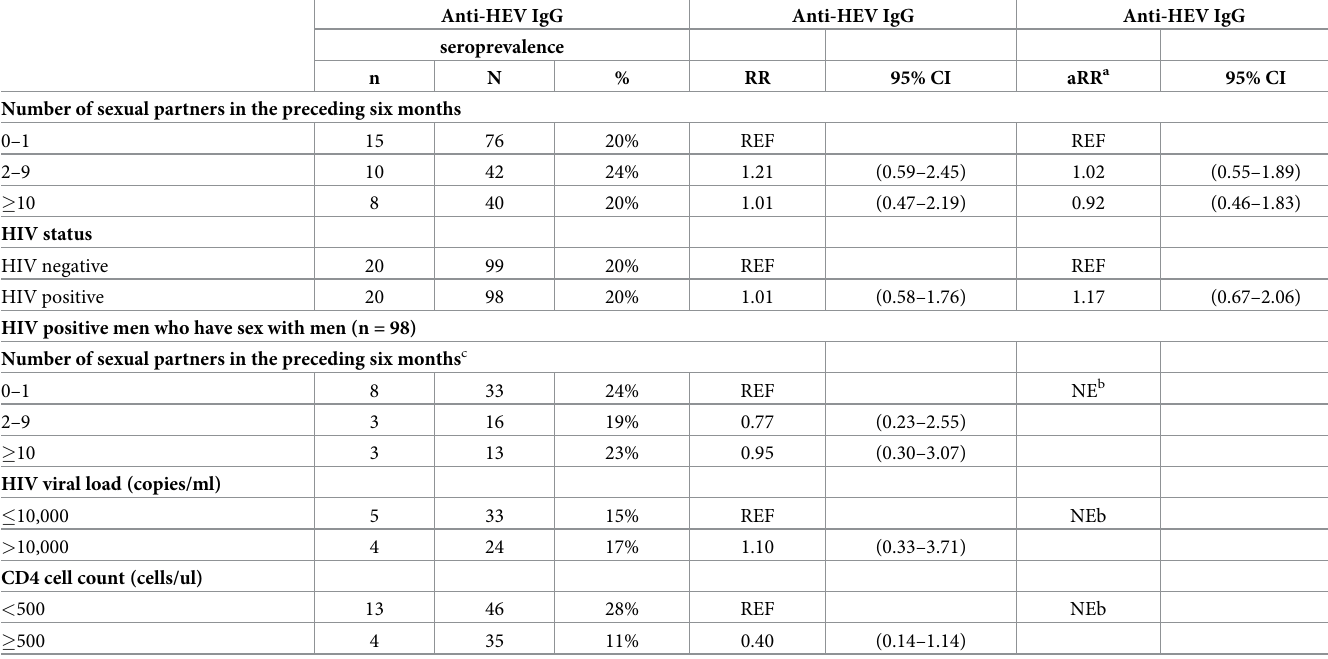
Table 4. Anti-HEV immunoglobulin G (IgG) seroprevalence among men who have sex with men (n =